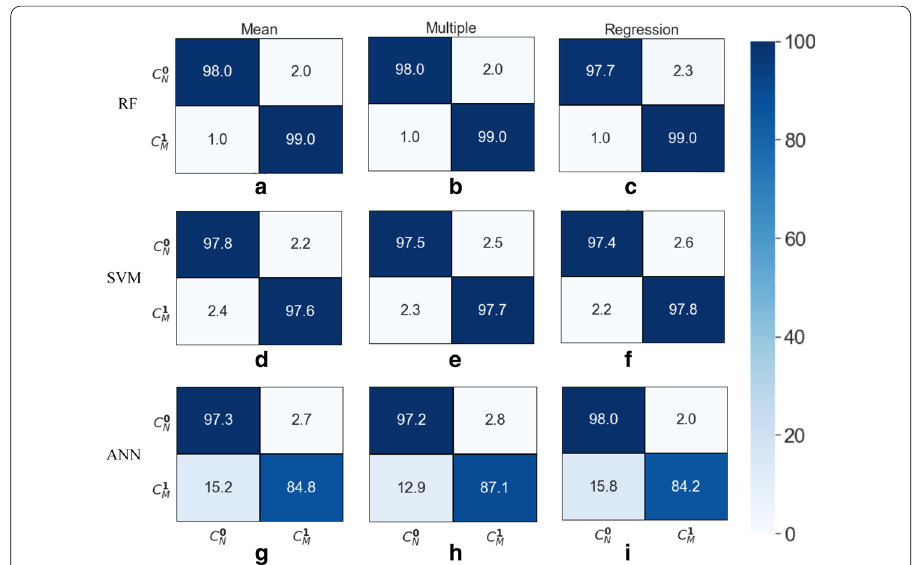
Fig. 5 Binary Classification Confusion Matrices. a – c are of RF with mean, multiple and regression imputation, d – f are of SVM with mean, multiple and regression imputation and g – i are of ANN with mean, multiple and regression imputation. In C ji , C is class, i is the label which is 0 or 1 and j shows that 0 is normal(N) and 1 is malicious(M) packet. In RF and SVM, there is very less % of false alarms but in ANN that % is slightly higher which is mostly due to the malicious traffic being classified as normal